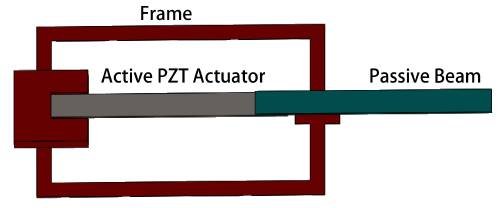
Figure 6. Solid model of compliant mechanism (frame), active PZT actuator, and passive, rigid beam for experimental prototyping.